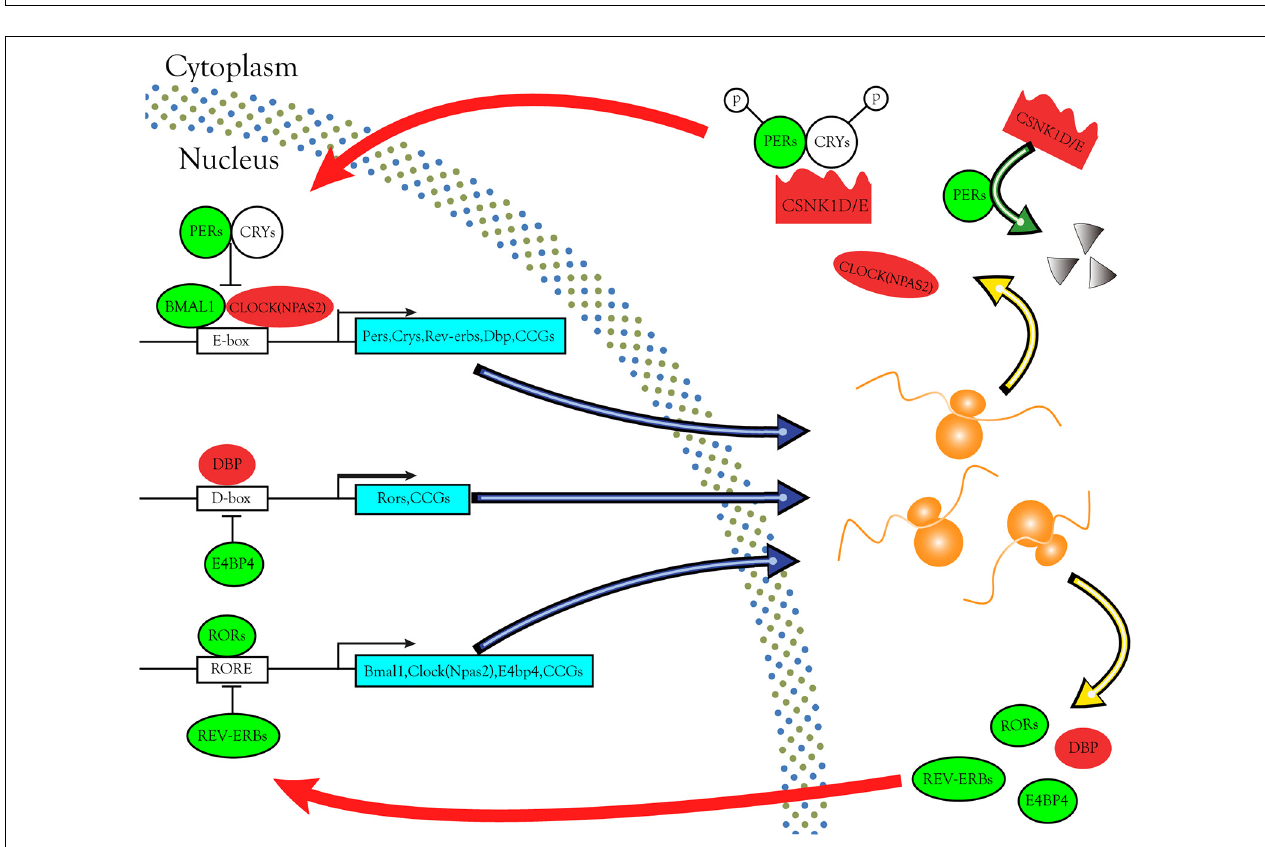
FIGURE 9 | Circadian rhythm pathways enriched in DERGs. The expression levels of DERGs are upregulated and downregulated in LIHC patients, which are indicated in the red and green modules,